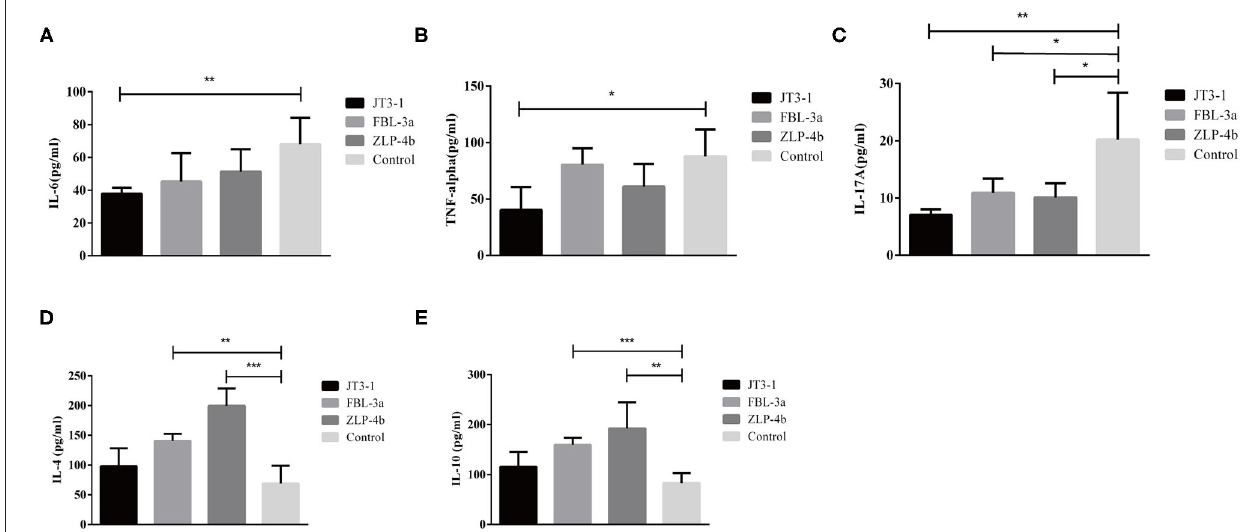
FIGURE 3 | Effects of the oral administration of probiotics on cytokine modulation. (A–E) IL-6, TNF- α , IL-17A, IL-4, and IL-10 level in the serum of mice. Data are expressed as mean ± SD. * P < 0.05; ** P < 0.01; *** P <